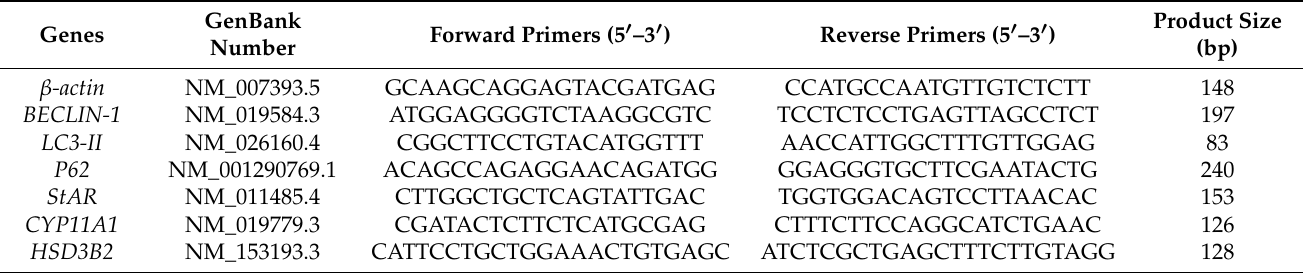
Table 2. Sequences of